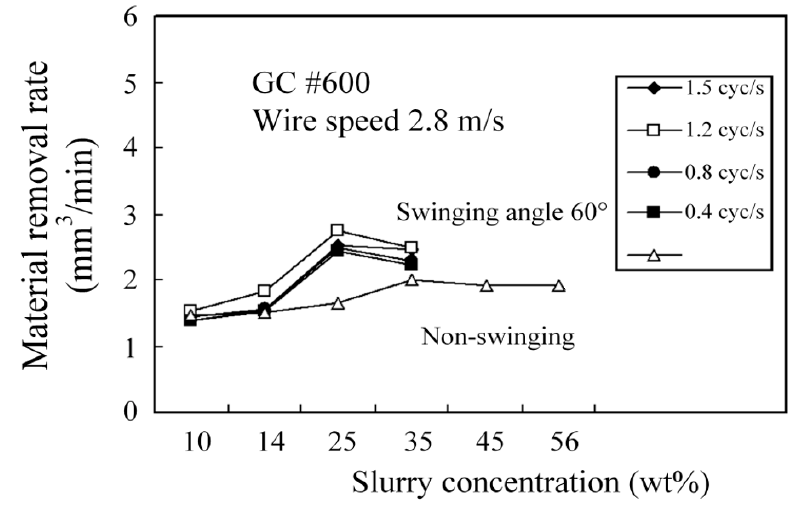
Figure 4. Comparison of swinging and non-swinging processes in terms of the MRR for different slurry concentrations and swinging frequencies.